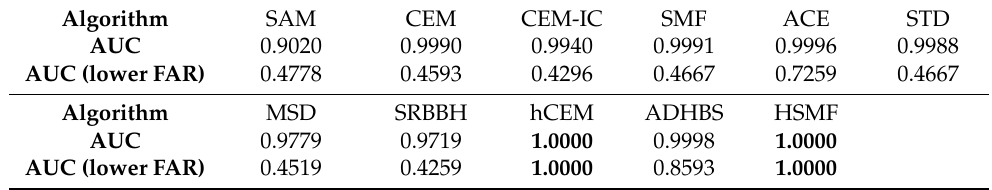
Figure 8. ( a ) ROC curves of different detectors on the Urban data. ( b ) The separability map of all detectors for the Urban data. Table 3. AUC values and AUC values at lower FAR of all detectors for the Urban data. Algorithm